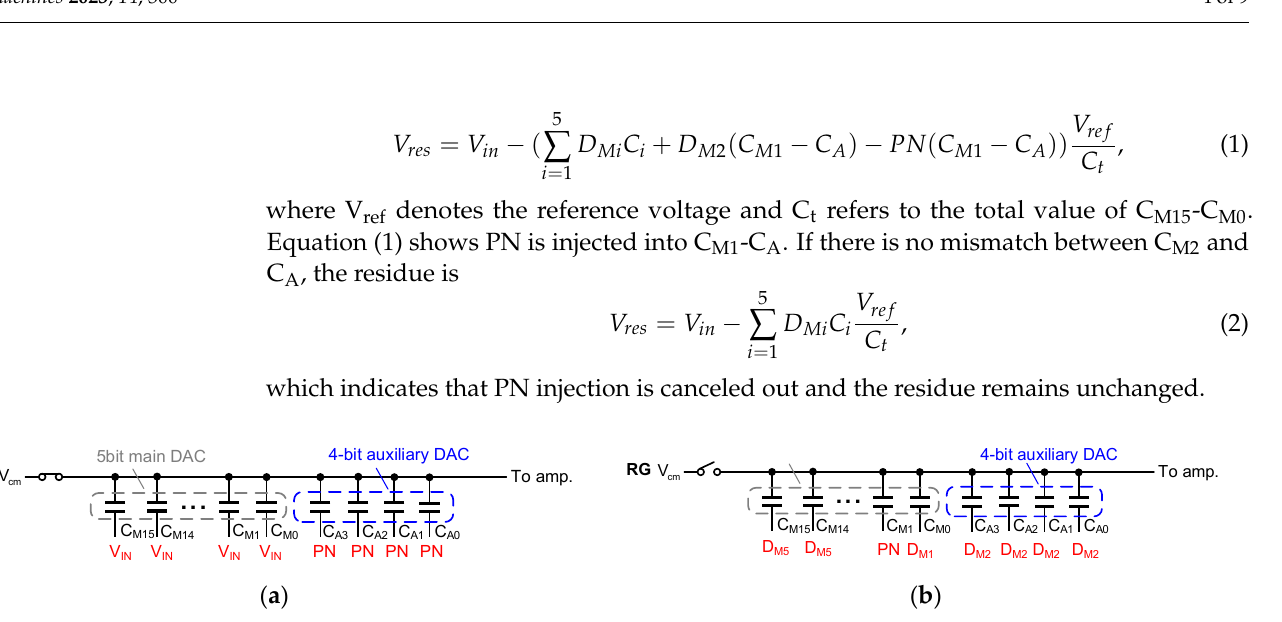
Figure 2. The connection configurations of the 1st stage CDAC when PN is injected into C M1 ( a ) in sampling phase; ( b ) in residue generation phase.